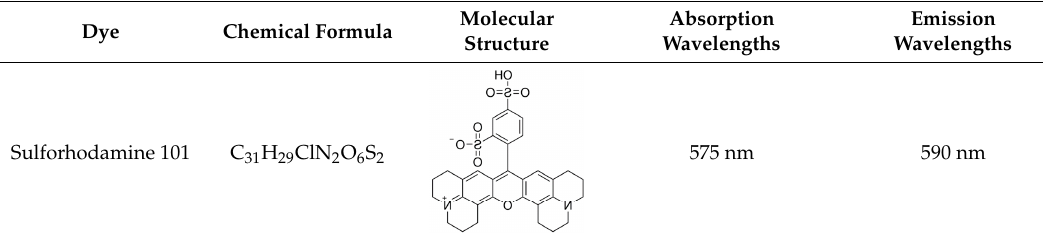
Figure 1. Schematic illustration of the experimental setup used for electrospinning of the dye-doped polymer solutions.